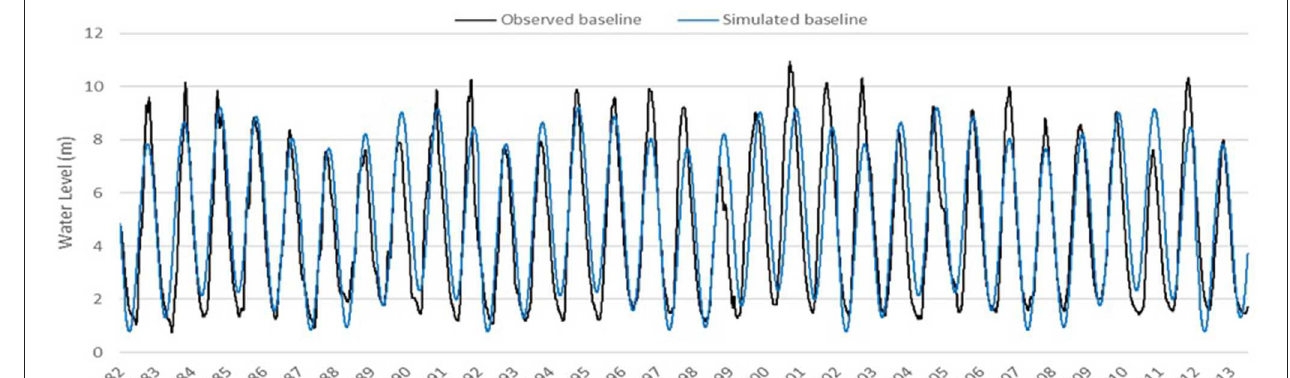
FIGURE 4 | Observed baseline and simulated baseline 1982–2013. Simulated baseline of water levels based on annual and ENSO-like harmonic identified in Fournier analysis.